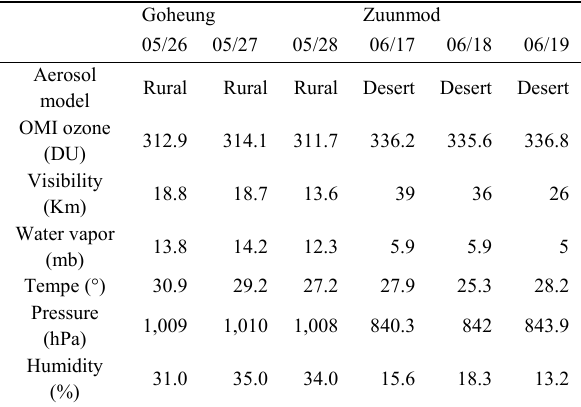
Table 2. Margin settings for A4 size paper